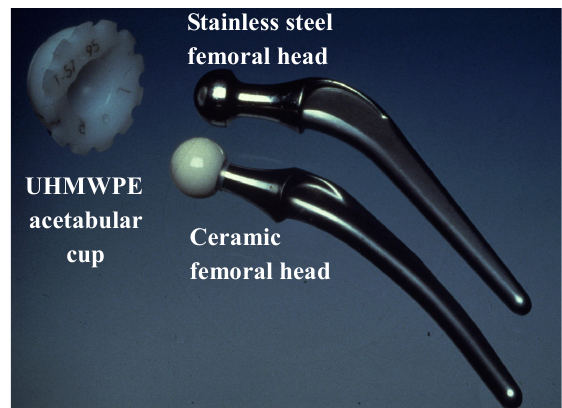
Fig. 1 Typical artificial hip joints with UHMWPE-on-metal and UHMWPE-on- ceramic material combinations